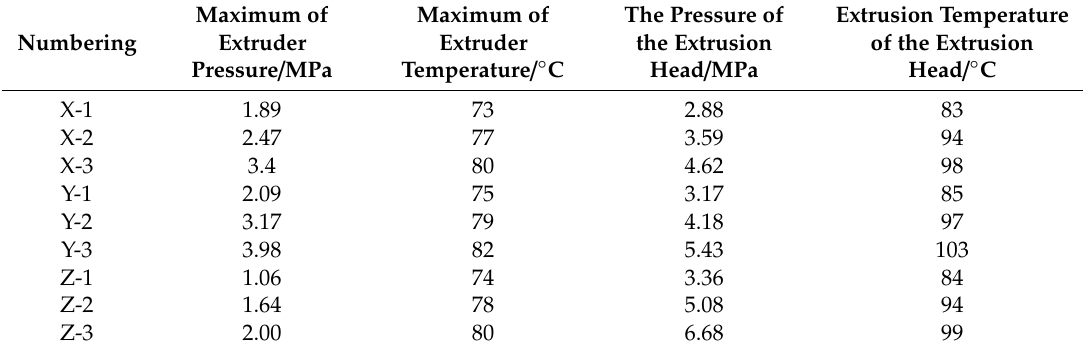
Table 4. The pressure and temperature value of the mixing rubber at the extruder and extruder